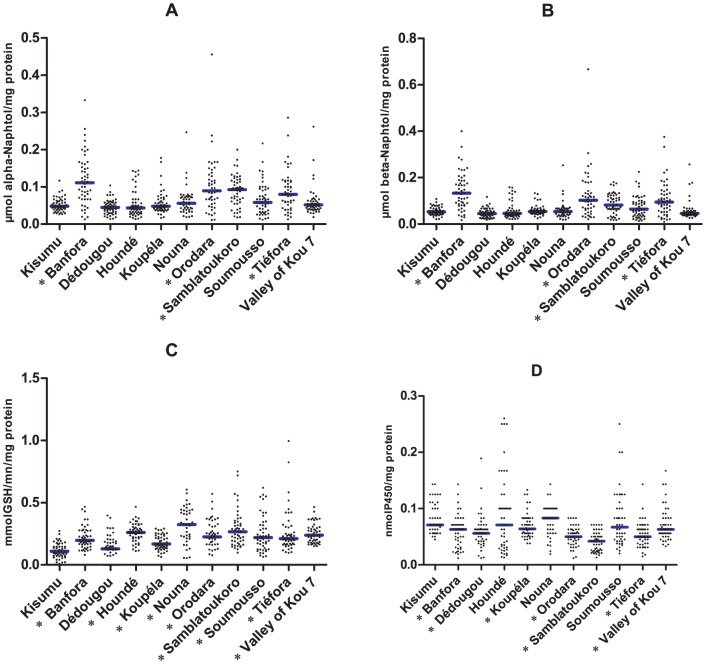
Detoxifying enzyme activities in An. gambiae s.l. mosquitoes collected form ten localities in Burkina Faso (2010).A) Non-Specific α Esterase activity, B) Non-Specific β Esterase activity, C) Glutathione-S-Transferase (GST) activity, D) P450 activity. Stars denote significant difference in activity level when compared to the An. gambiae Kisumu reference strain.